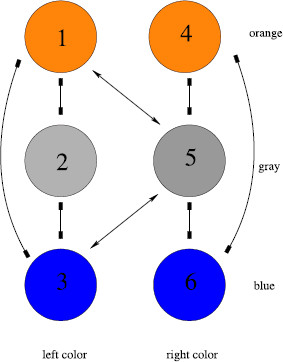
Network for Hong and Shevell [16] experiment